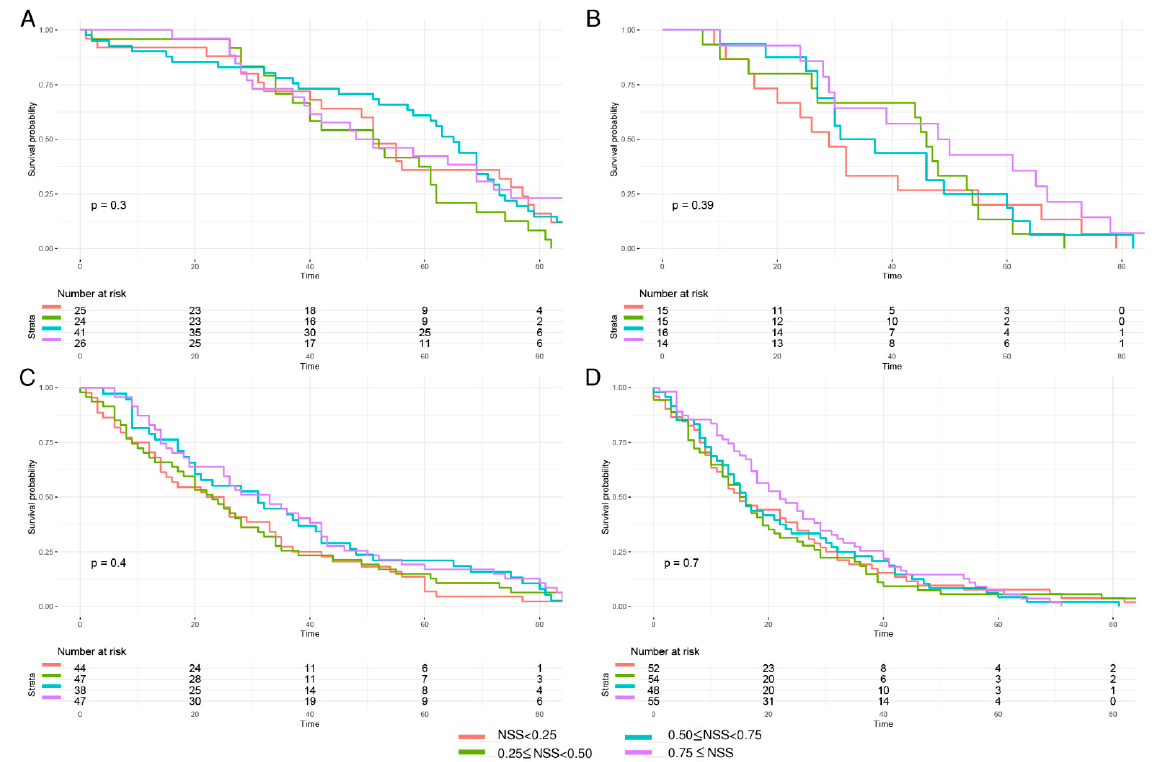
Figure 4. Kaplan–Meier curves of overall survival in GSRCC stratified by quantile NSS values in each T stage group. ( A ) The quantile cutoff values in T1 were 0.9625765, 0.9740264, 0.9859350; ( B ) the quantile cutoff values in T2 were 0.7540709, 0.8635734, 0.9161756; ( C ) the quantile cutoff values in T3 were 0.7227524, 0.8058663, 0.8680536; ( D ) the quantile cutoff values in T4 were 0.6129243, 0.7015987, 0.7956004.